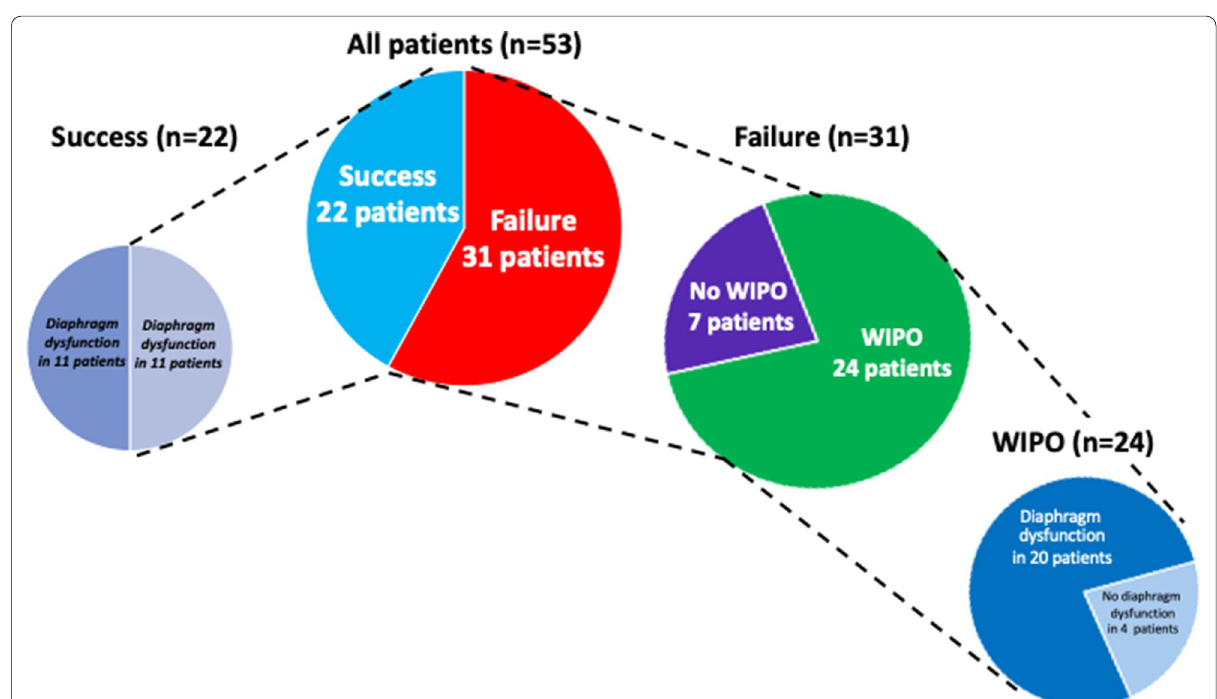
Fig. 2 Outcomes of the spontaneous breathing trial presented with the proportion of patients with diaphragm dysfunction and weaning-induced pulmonary oedema